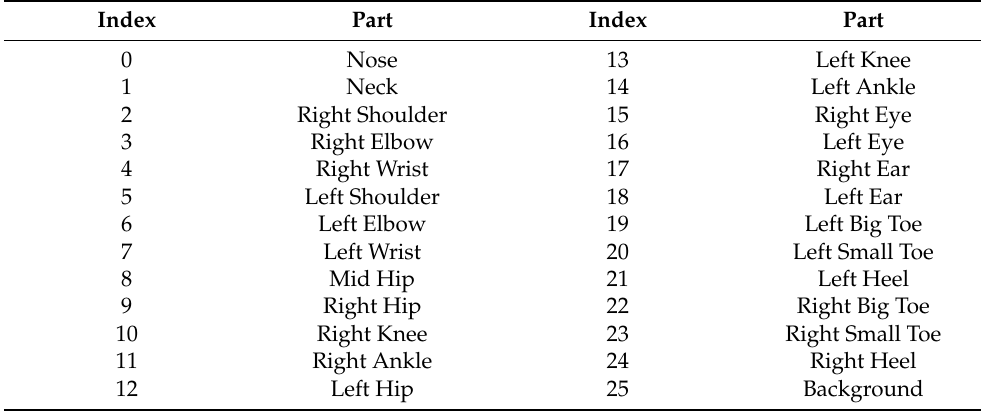
Table 3. Joint data from skeleton